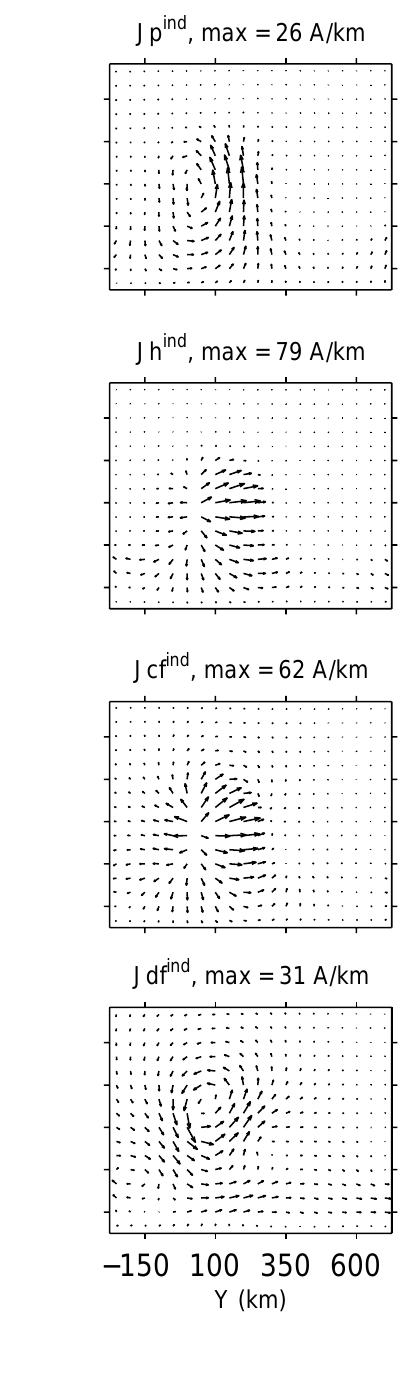
of the divergence-free input currents. The exact calculation gives a somewhat smoother vector field, which also spreads out in a larger area than where d(J 1 df )/dt is